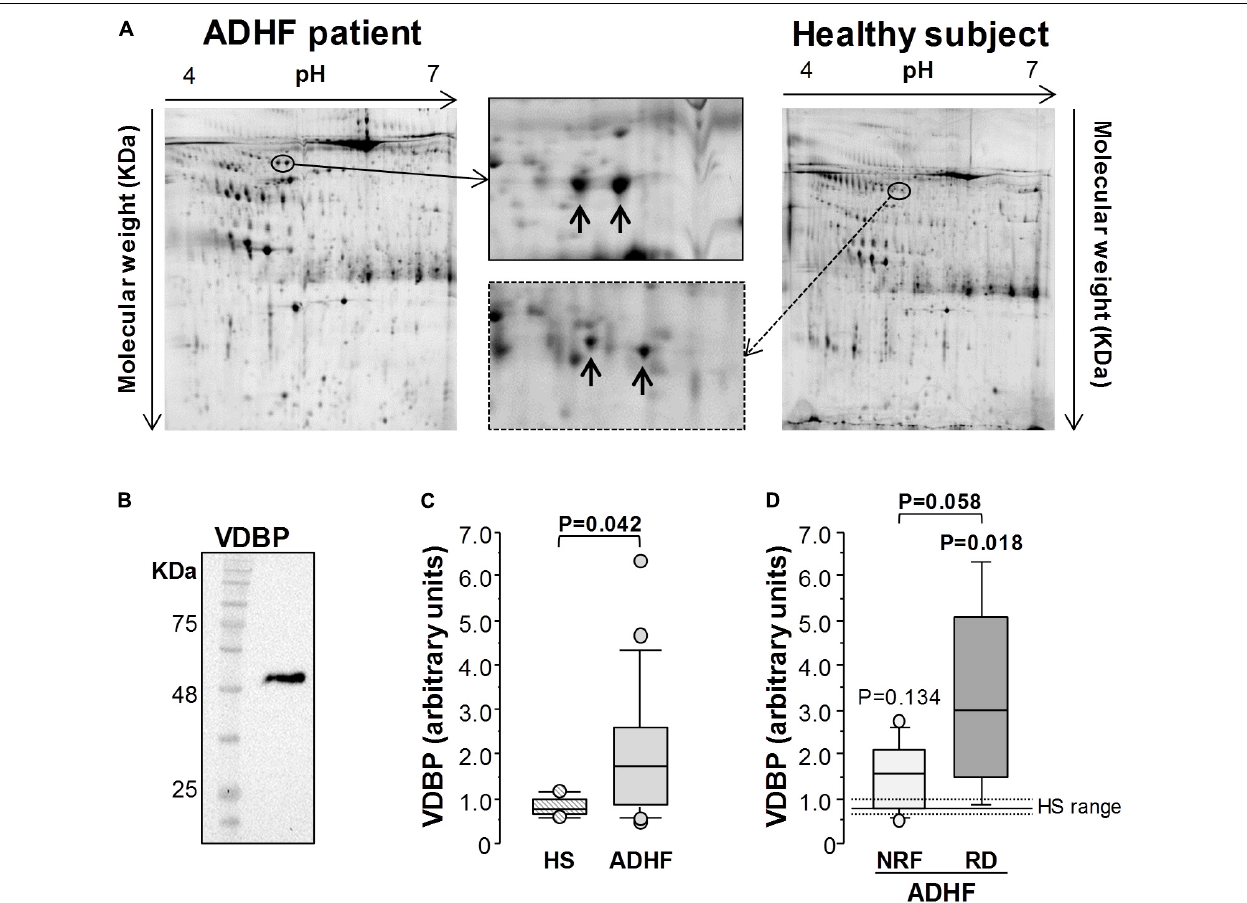
FIGURE 2 | Proteomic analysis of urine samples. (A) Representative 2-DE image of human urine samples in a pI range of 4–7 and 12% SDS-PAGE gels. Vitamin D binding protein (VDBP) was identified as 2 spots (pI: 5.25–5.30; Mw: 50.3 KDa) in patients with ADHF ( N = 17) and healthy subjects ( N = 6). (B) Western blot analysis showed one single band for VDBP in urine samples. (C,D) Box plot diagrams [median (IQR)] of the intensity of both VDBP spots at hospital admission. In (C) , comparison between patients with ADHF and heathy subjects (HS). (D) Differences in VDBP intensity between patients with ADHF with ( N = 12) and without ( N = 5) renal dysfunction (RD and NRF for GFR values below and above 60 ml/min/1.73 m 2 , respectively). The Mann-Whitney test was used for comparison between groups in C and D. Statistical significance for P <